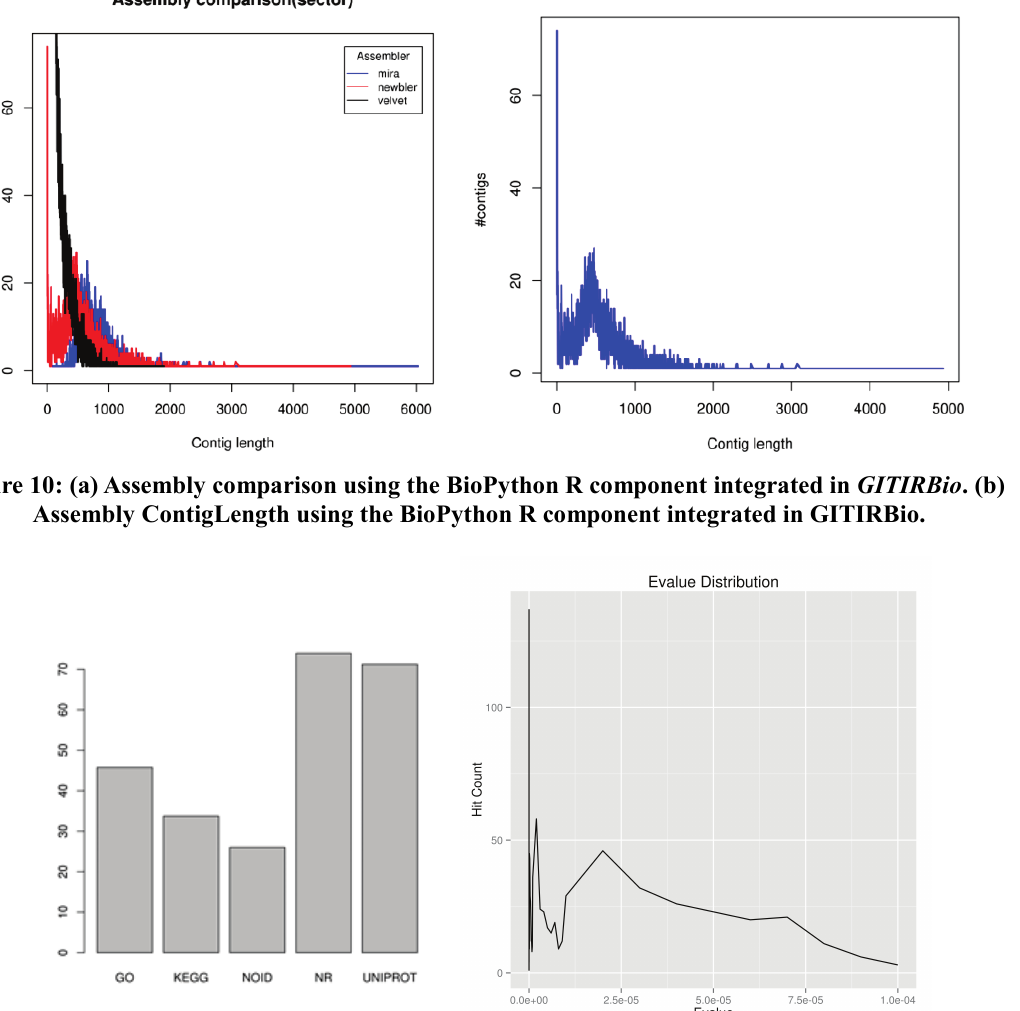
Figure 11: (a) Annotation using the BioPython R component integrated into GITIRBio , where x-axis the repository and y-axis is # annotation hits found. (b) Annotation E-Value using the BioPython R component integrated into GITIRBio